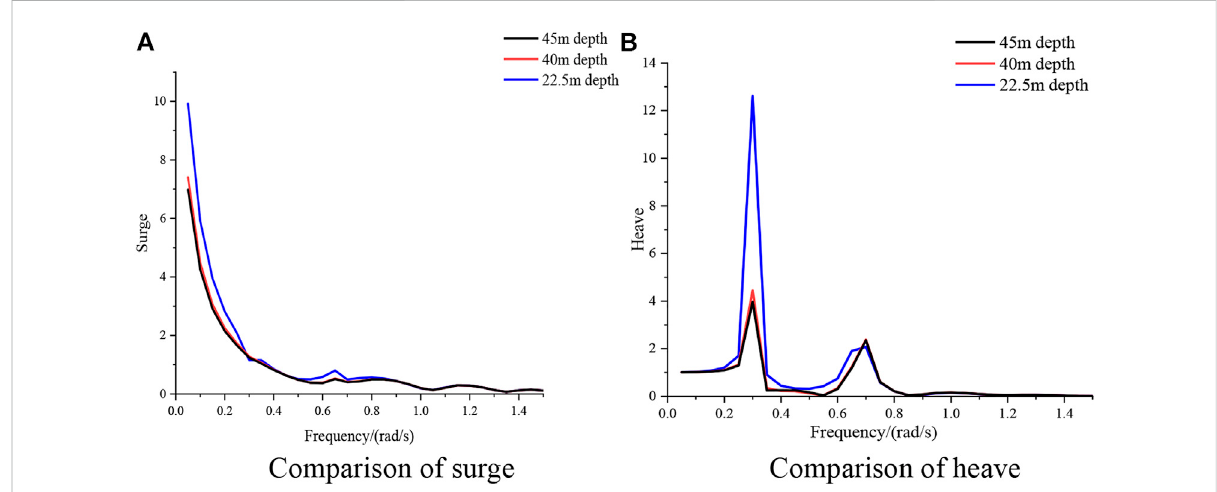
FIGURE 17 Comparison of the RAOs at different depths. (A) . Comparison of surge (B) . Comparison of